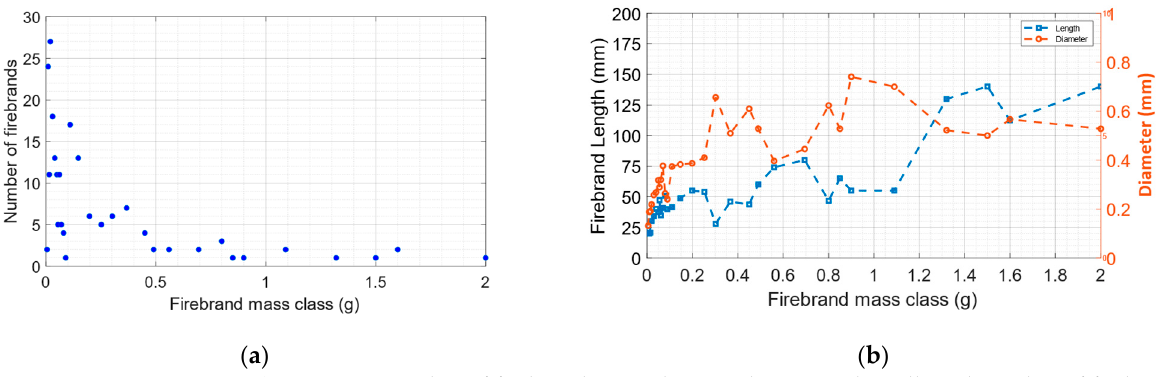
Figure 2. ( a ) Number of firebrands in each mass class (30). The collected number of firebrands are decreasing with increasing mass. The length and diameter of firebrands’ show an increasing trend with the mass classes in ( b ).